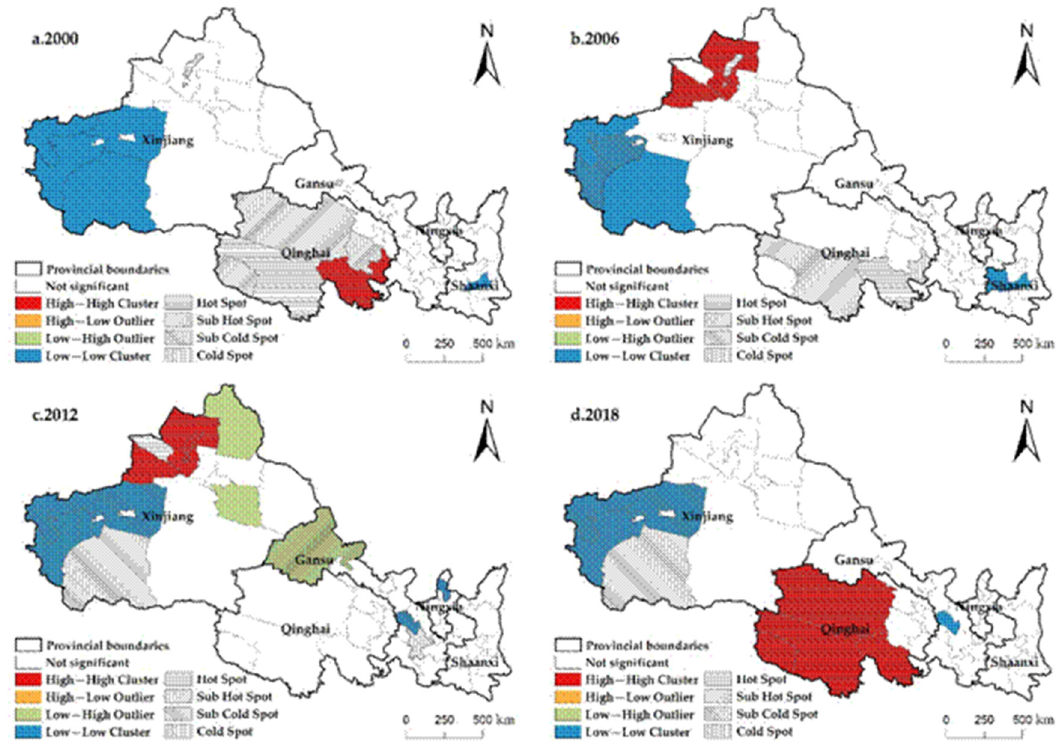
Figure 5. The LISA aggregation and hotspots of AWUE in Northwest China. According to the distribution characteristics of local autocorrelation and hot spots, the distribution of high-value and low-value areas does not show obvious spatial trend characteristics, nor does it show consistent rules with the level of urban economic devel- opment. However, the following conclusions can be drawn from the figure: (1) The H–H type basically coincides with hot spot areas, but the change in a H–H area is more volatile from 2000 to 2018. It is distributed from Golog and Huangnan in Eastern Qinghai in 2000 to Ili and Tacheng in Northwestern Xinjiang in 2006 and 2012, and then to Haixi and Yushu in Western and Southern Qinghai in 2018. These cities and their neighboring cities are rich in water resources and have high AWUE, and the cities have significant, positive impacts on neighboring cities. (2) There is no cold point area with agricultural water use efficiency in Northwest China from 2000 to 2018, while the L–L type is more often in secondary cold point areas, and the change in L–L type is stable. These areas are basically located in the southwest of Xinjiang Kizilsu, Kashgar, Aksu, and other cities. Lanzhou is the only provincial capital city of the L–L type, which does not drive the surrounding cities to develop into an agricultural mode of high-efficiency water use. Lanzhou is the only provincial capital city in the L–L model that has not promoted the development of the surrounding cities to an agricultural model of high-efficiency water consumption. The AWUE of the low-concentration cities in Shaanxi and Ningxia have gradually improved, so they no longer exemplify an L–L model. (3) L–H and H–L are rarely distributed and sporadic over the years. In 2012, Altay, Tulufan, and Jiuquan were characterized mainly by low–high agglomeration and consisted mainly of sub-hot spots. The AWUE in these areas is low, and the agricultural production base is weak; however, the efficiency of the neighboring cities is relatively high. From 2000 to 2018, the scope agglomeration of H–L and L–H has changed from nothing, to existence, and then to nothing. The AWUE of those cities basically showed a gradual improvement, with room for further